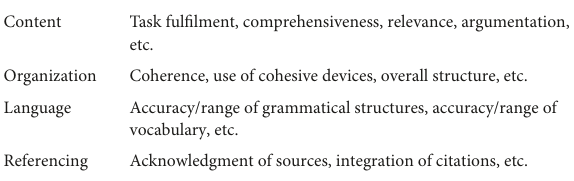
TABLE 1 Marking criteria of the take-home